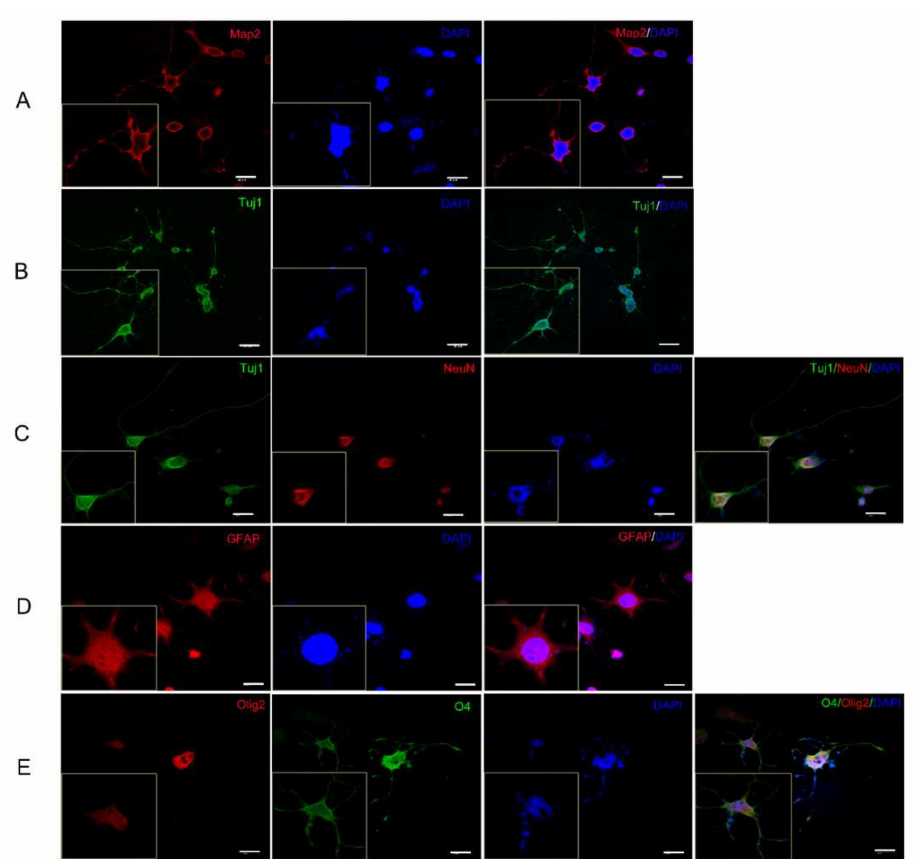
Figure 3. Differentiation of hiNSCs-1 in vitro. hiNSCs-1 differentiated into neurons (marked by Tuj1, Map2, and NeuN, A – C ), astrocytes (marked by GFAP, D ), and Oligodendrocytes (marked by O4 and Olig2, E ) after 2–3 weeks culture in NDM, ADM, and ODM, respectively. Scale bars are 40 µ